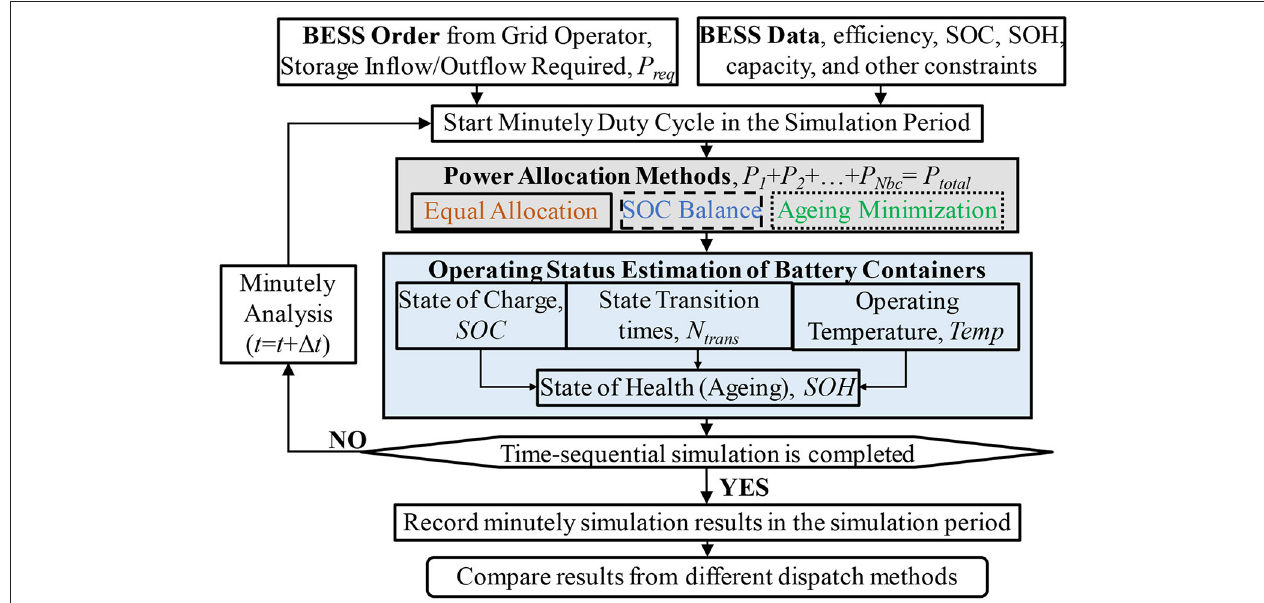
FIGURE 2 | Methodological flowchart for evaluating different power allocation methods.